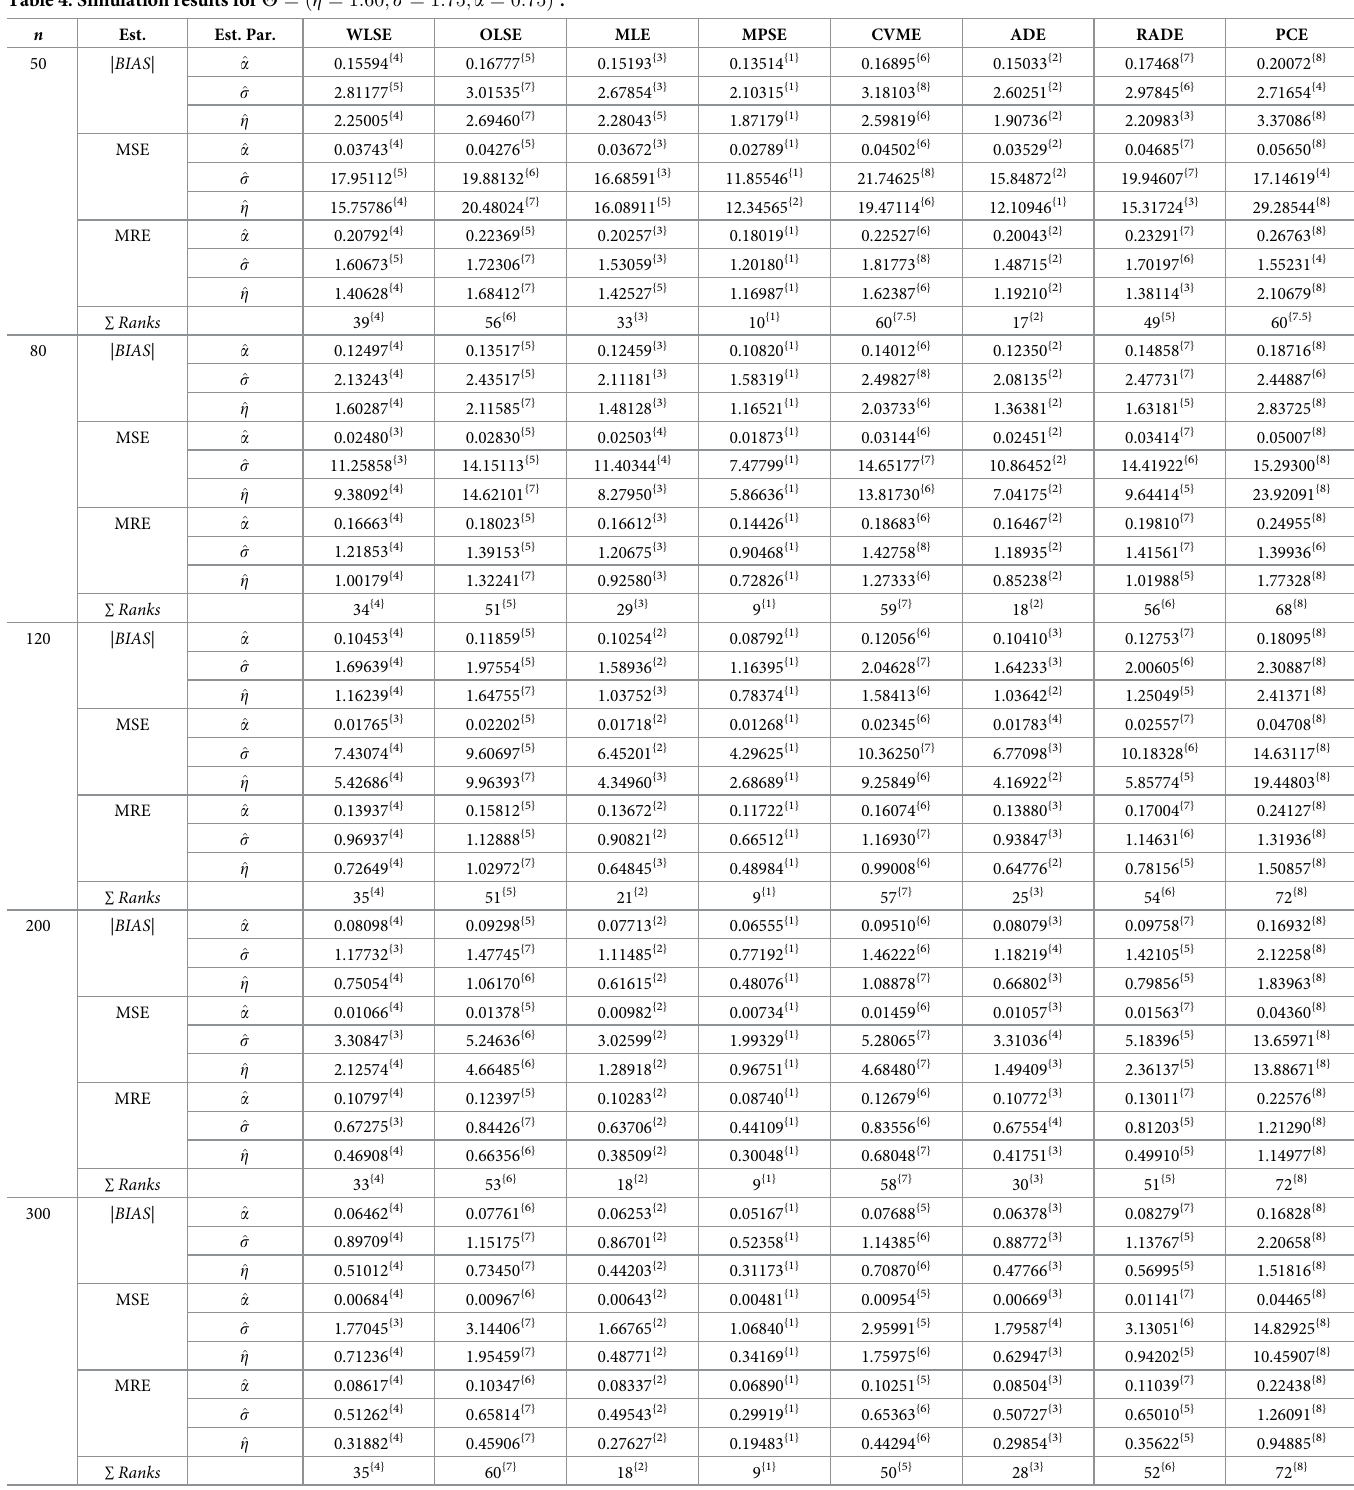
Table 4. Simulation results for Y ¼ ð Z ¼ 1 : 60 ; s ¼ 1 : 75 ; a ¼ 0 : 75 Þ ⊺ . n